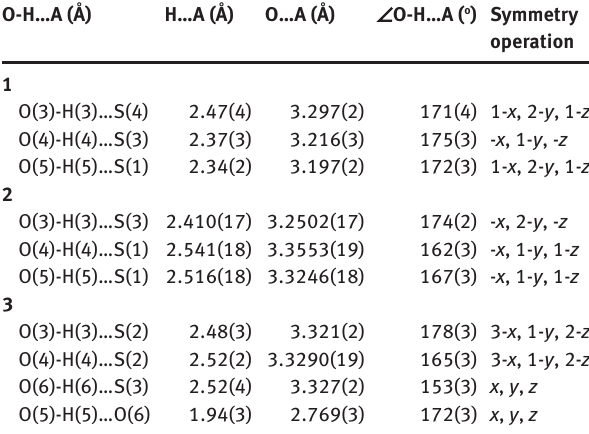
Table 2 Hydrogen bond data for 1 – 3 .